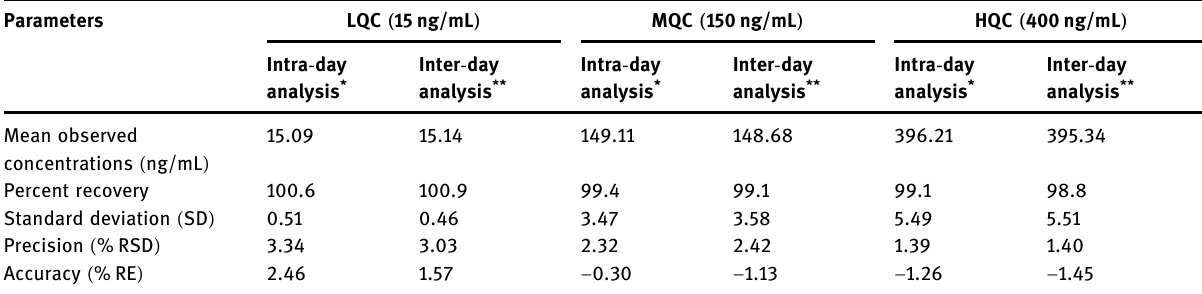
Table 1: Intra - and inter - day precision and accuracy results of the developed method for NT in the quality control